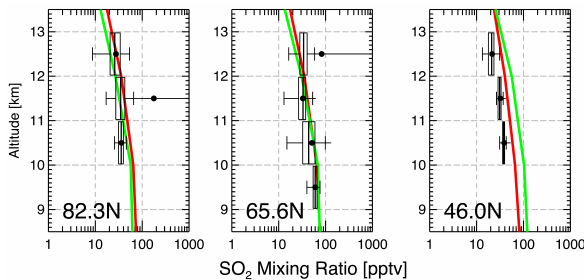
Fig. 4. Vertical profiles of modelled SO 2 at mid and high latitudes of the Northern Hemisphere in comparison with observational data from the NASA SOLVE campaign, conducted between December 1999 and March 2000 (Lee et al., 2003). Observations, in black, were rebinned to 1km intervals. Shown are medians and the interquartile range (IQR), expressed as 0.25 and 0.75 percentiles, of the samples. Circles mark arithmetic mean values. The spread of the data is shown as whiskers denoting 1 . 5 × IRQ values, and outliers larger than that. Only measurements above the tropopause were considered. Model data are seasonal averages from 1999/2000 zonal means (DJF in red, MAM in green).